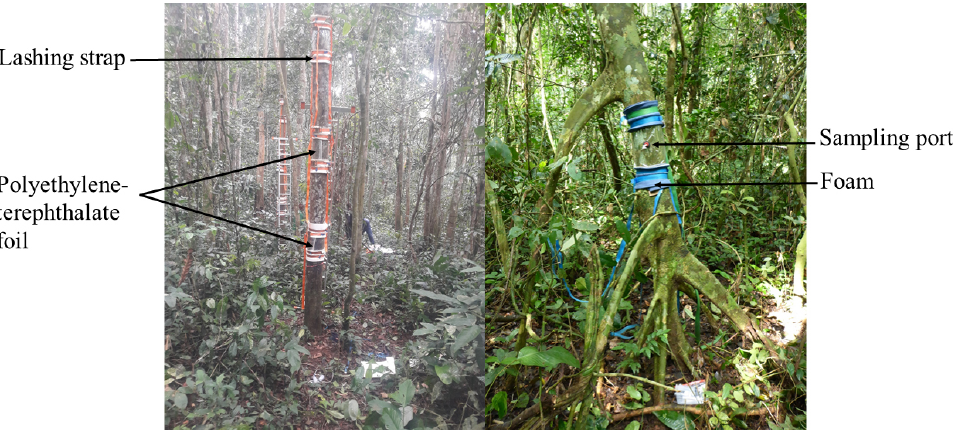
Figure B2. Sampling set-up for stem nitrous oxide (N 2 O)-flux measurement at three stem heights in a rainforest in the Congo Basin,